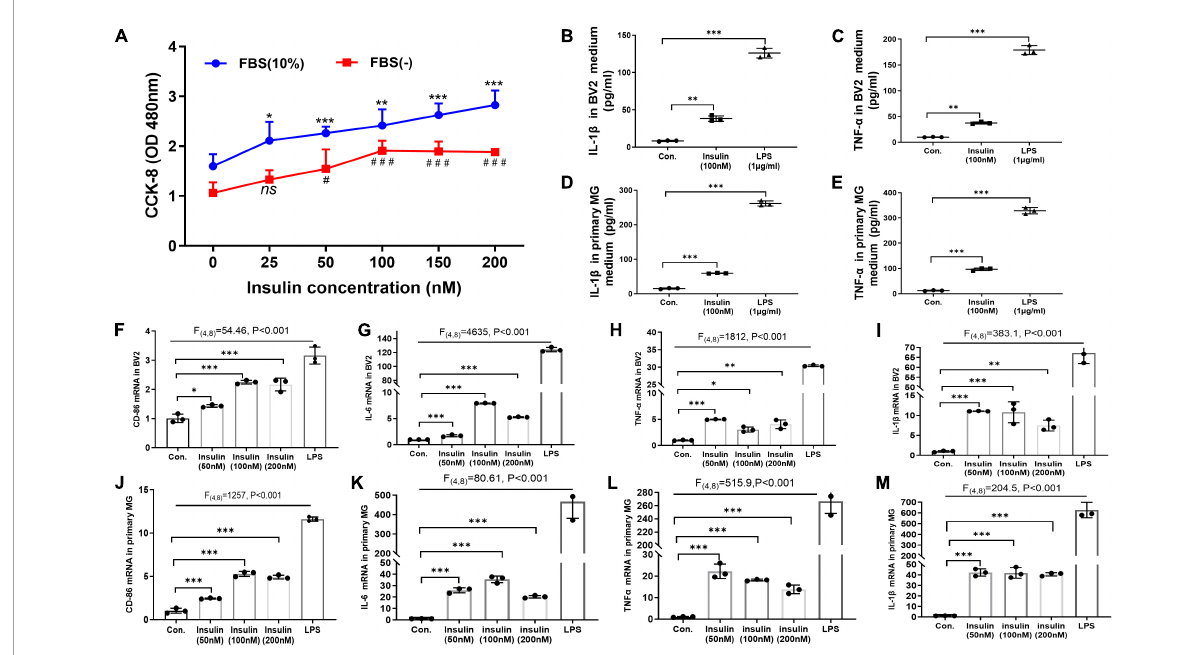
FIGURE4 Hyperinsulinemia promoted microglia proliferation and M1-like polarization in vitro . (A) CCK-8 assay detected the BV2 cell proliferation with different doses of insulin in the free or 10% FBS culture condition. (B) The level of pro-inflammatory cytokine IL-1 β in BV2 cell culture supernatant. (C) The level of pro-inflammatory cytokine TNF α in BV2 cell culture supernatant. (D) The level of pro-inflammatory cytokine IL-1 β in primary microglia culture supernatant. (E) The level of pro-inflammatory cytokine TNF α in primary microglia culture supernatant. (F–I) The mRNA expression of M1 marker CD86 (F) , IL-6 (G) , TNF α (H) , and IL-1 β (I) in BV2 cells after insulin treatments with different doses. (J–M) The mRNA expression of M1 marker CD86 (J) , IL-6 (K) , TNF α (L) , and IL-1 β (M) in primary microglia after insulin treatments with different doses. Cells treated with 1 µ g/ml LPS for 24 h were served as positive controls for M1 inflammatory status. Data are expressed as mean ± SD. ∗ , # p < 0.05, ∗∗ p < 0.01, ** ∗ , ### p < 0.001. n = 3 per